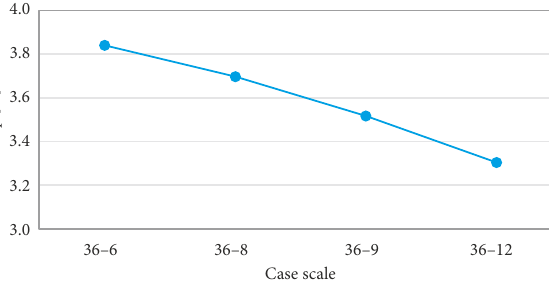
Figure 7. The trend of gap with the increasing vessels